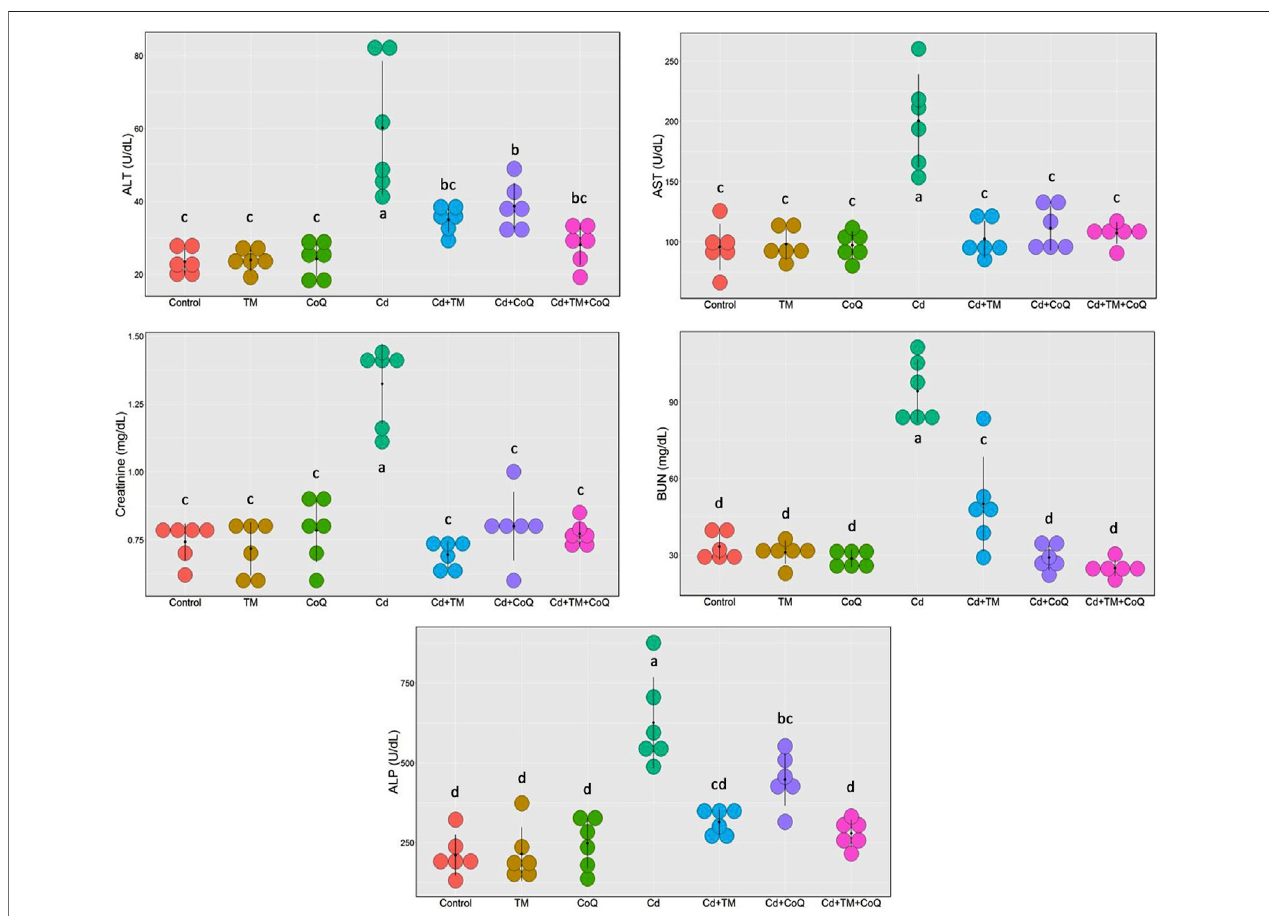
FIGURE 2 | Dot plot of liver and kidney biochemical parameters following treatment with Cd, TM, and CoQ. Values exhibited are mean ± SD ( n = 6).